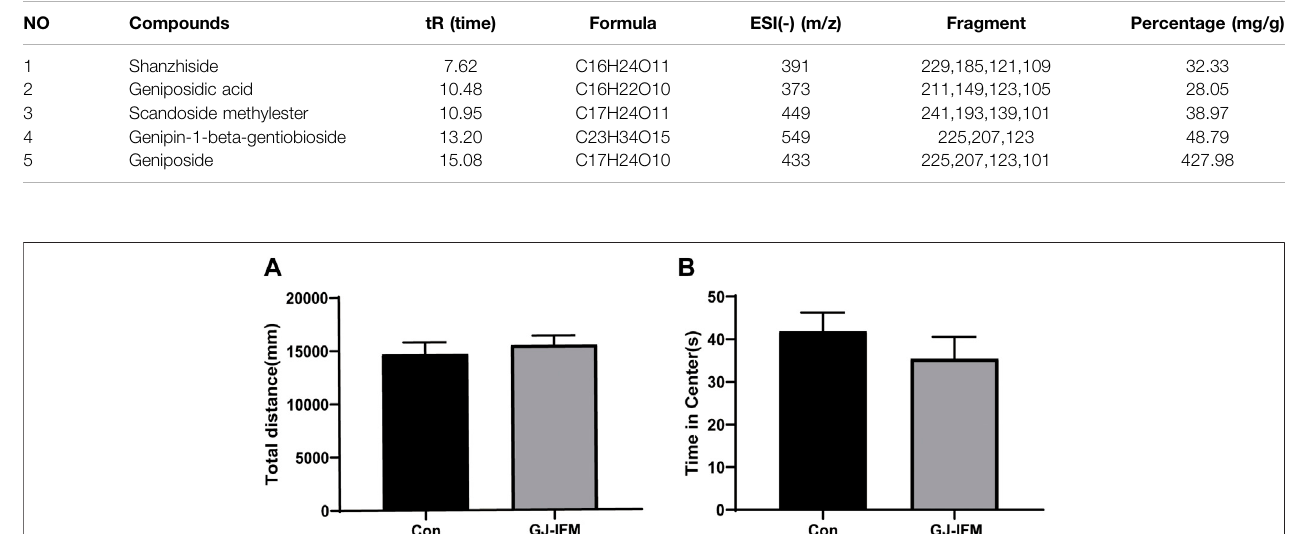
FIGURE5| The effects ofasingle doseofGJ-IFMon OFTat 1 din KM mice. (A) Total distance traveled wasnot affectedby thetreatment. t -test, p > 0.05;control vs . GJ-IFM. (B) Time spent on the central zone was not affected by the treatment t -test, p > 0.05; control vs . GJ-IFM.